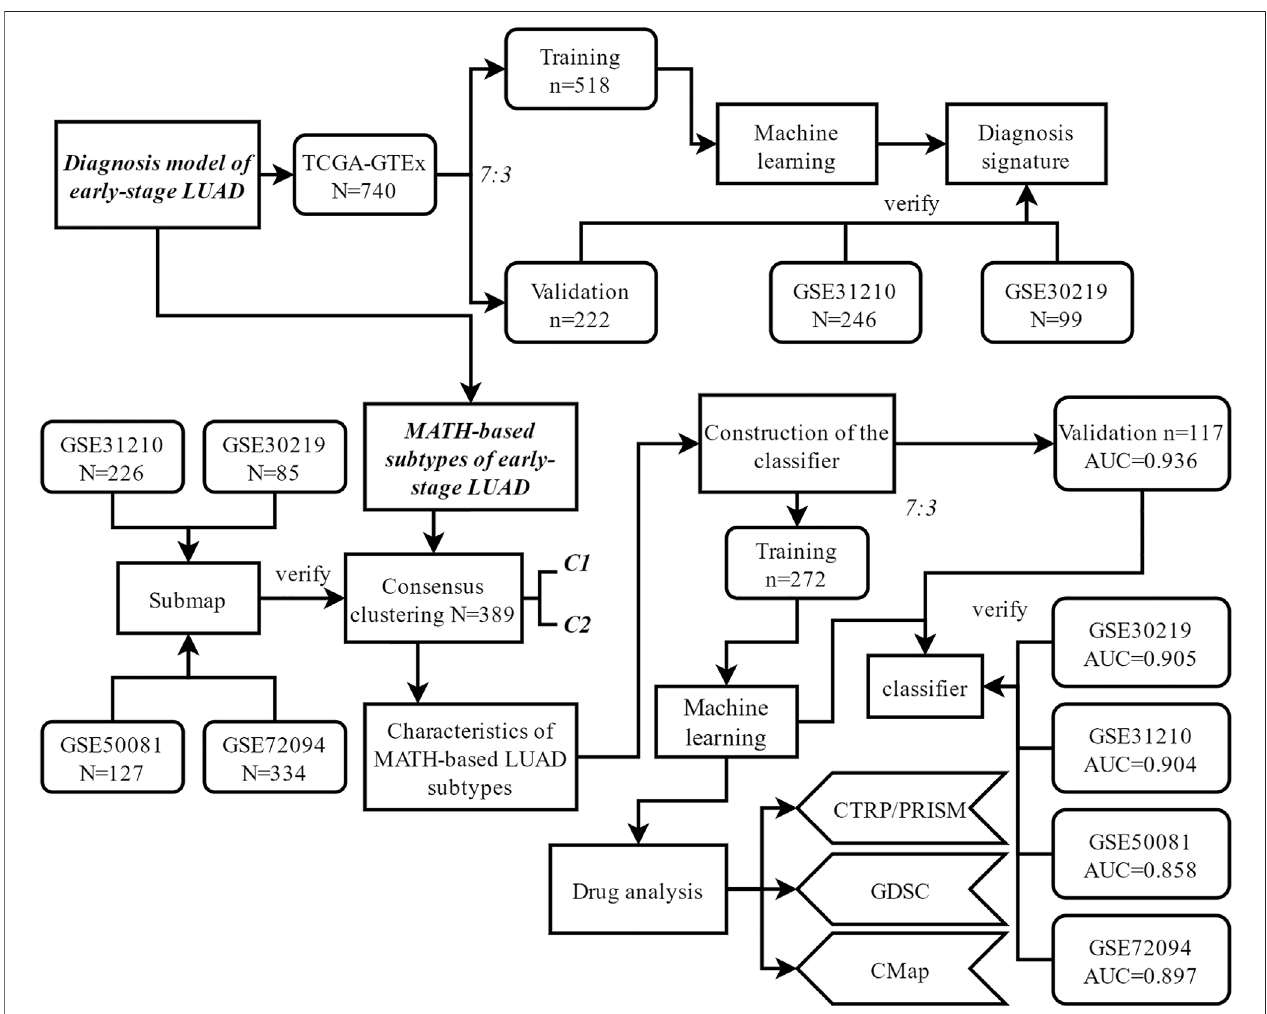
FIGURE 1 | Flowchart of this